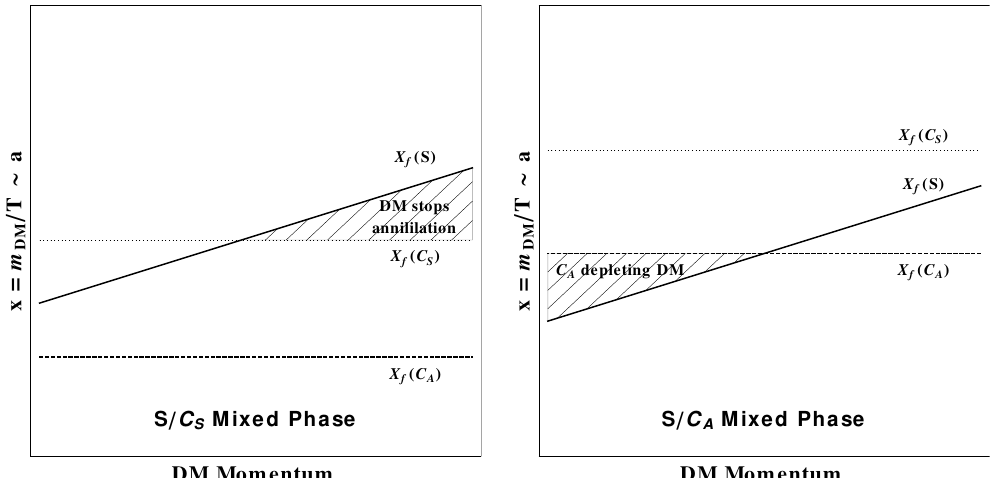
Figure 2 . Schematic illustrations of the mixed coscattering/coannihilation phases. Left: the S = C S mixed phase: for low (high) momentum modes S freezes out earlier (later) than C S . Right: the C A = S mixed phase: for low (high) momentum modes C A freezes out earlier (later) than S . momentum modes controlled by C , intermediate momentum modes governed by S , and A high momentum modes determined by C S